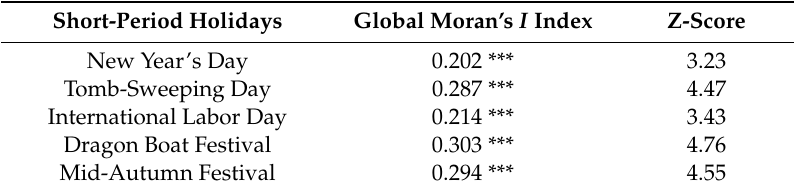
Table 4. Global Moran’s I index and its statistical significance for the geographical concentration index of scenic